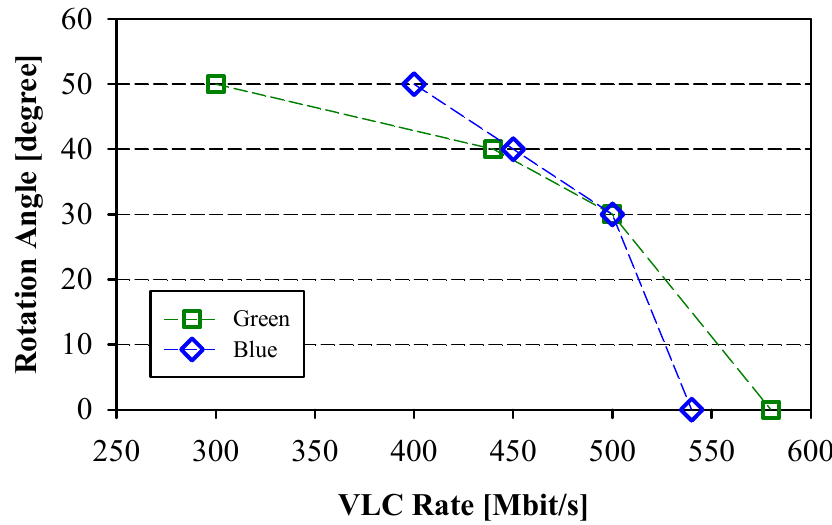
Figure 8. Obtained corresponding modulation rates of VLC (Green) and VLC (Green) within the FEC level under the different rotation angles from 0  to 50  .